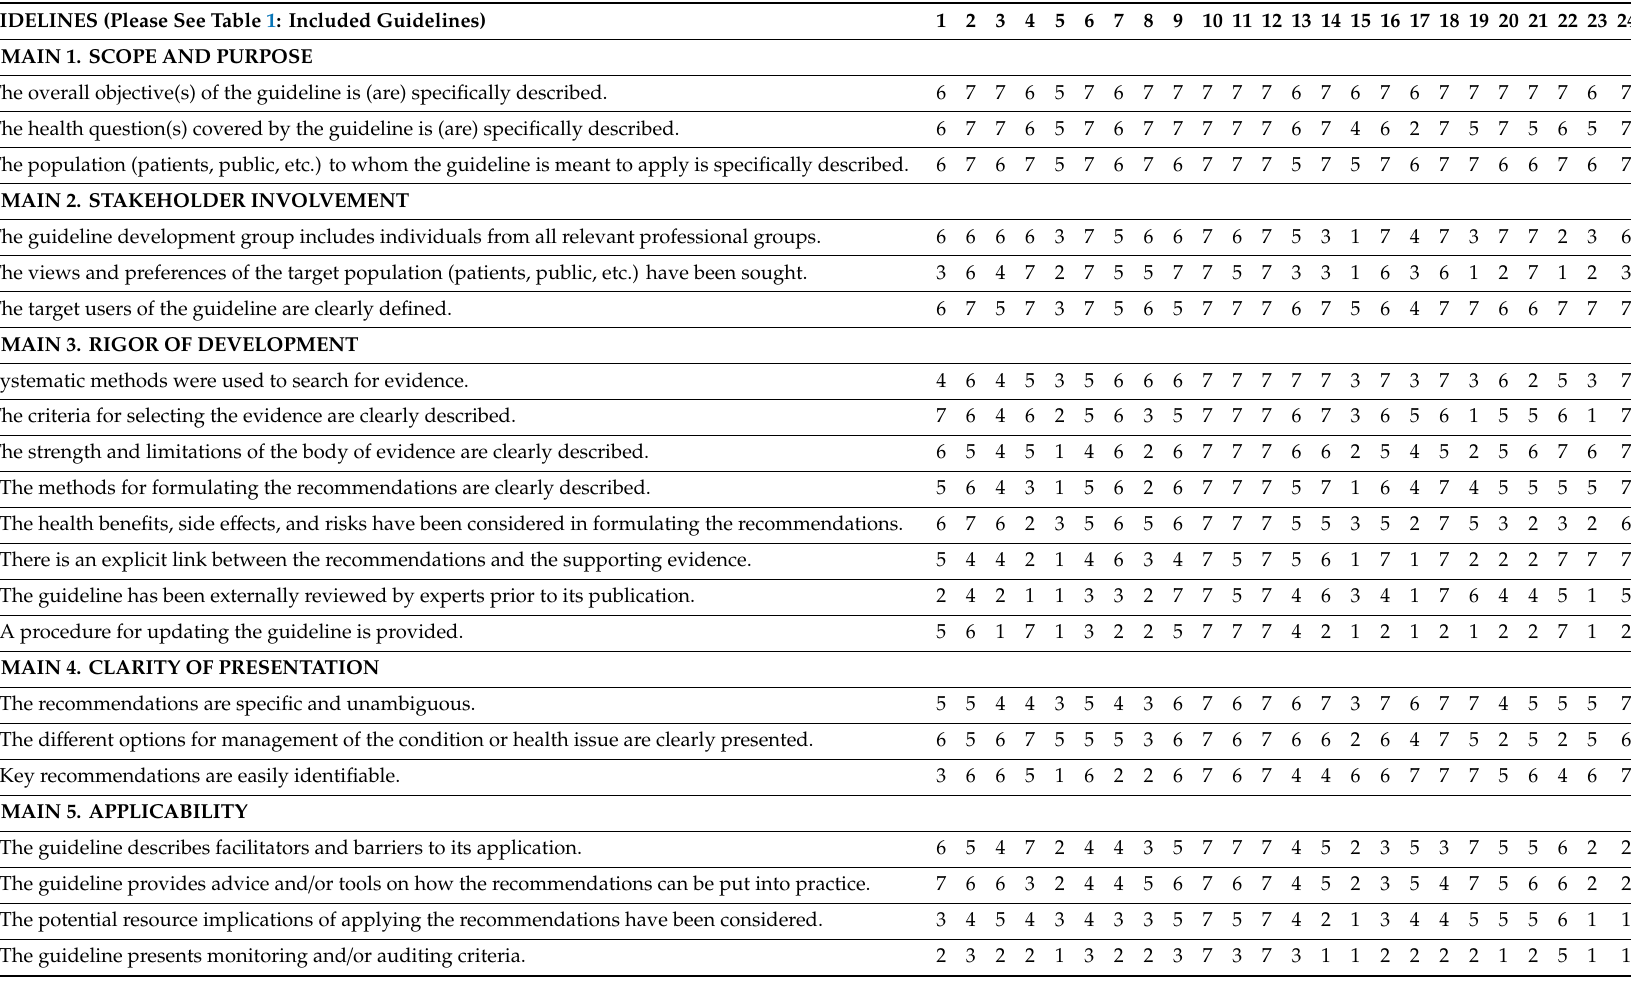
Table 2. Full version of the AGREE II instrument (Strongly Disagree—1, Strongly Agree—7). GUIDELINES (Please See Table 1: Included